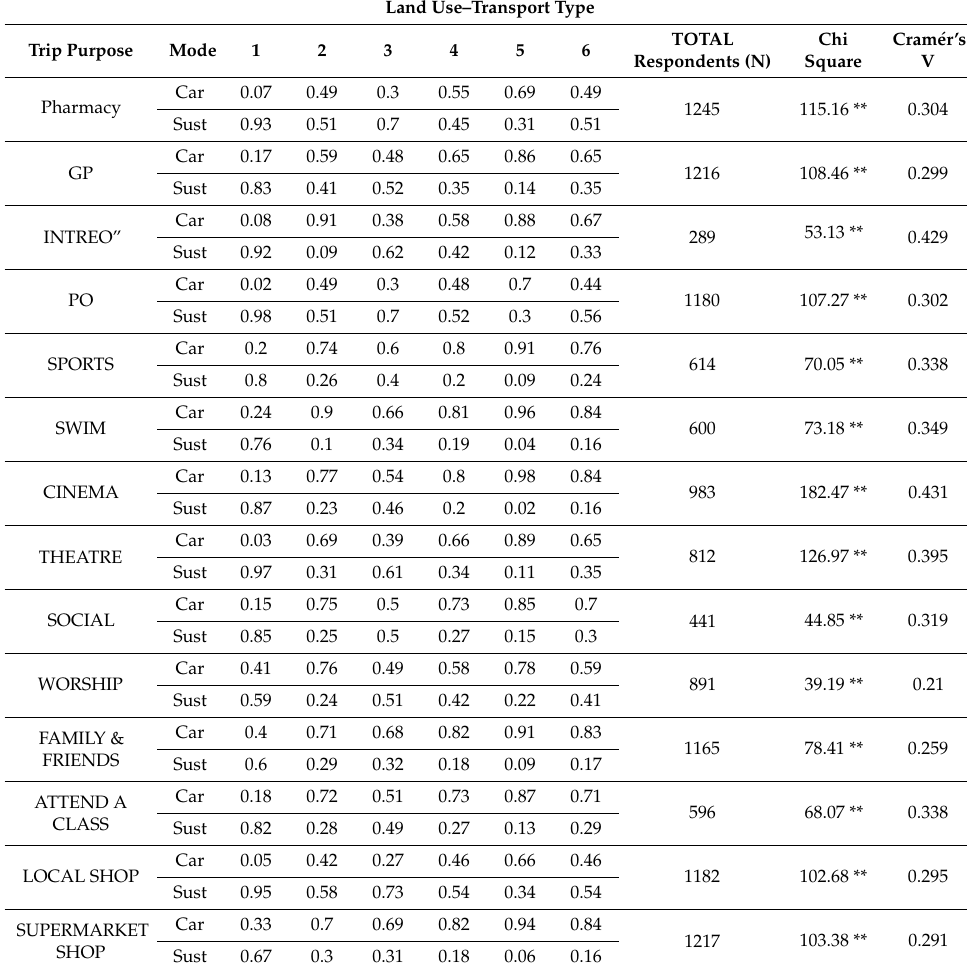
Table 4. Strength of the Association between the Mode Use (proportion) and the Land Use–Transport Type (LUTT) [Cram é r’s V].